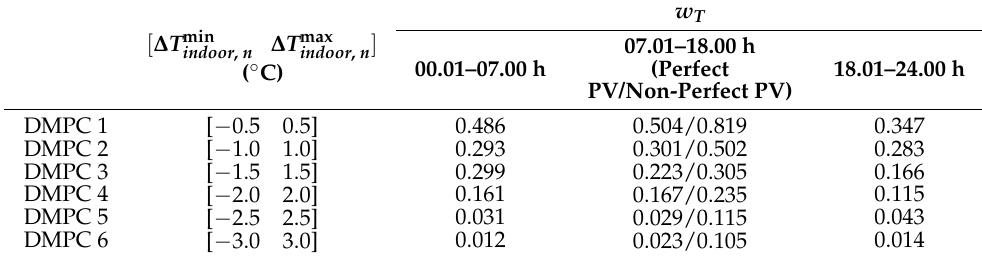
Figure 8. Case studies: ( a ) PV power deviation, ( b ) wind power deviation, ( c ) random load deviation, ( d ) outdoor temperature, and ( e ) number of IAC. Table 2. Weighs of indoor temperature deviations for